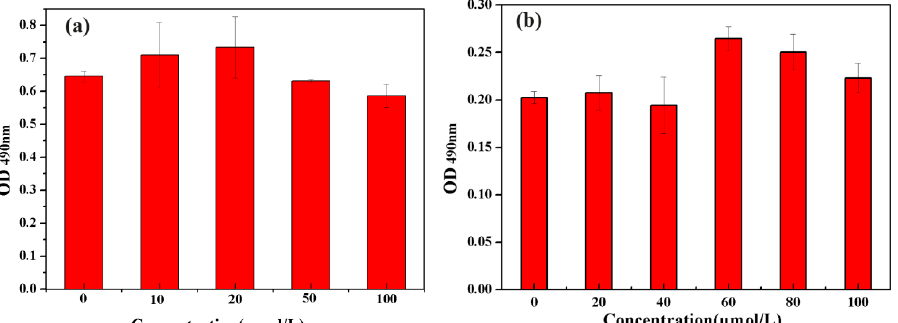
Figure 3. Cellular activity of MC3T3-E1 cultured with different concentrations of ( a ) HKB and ( b ) SrHA.